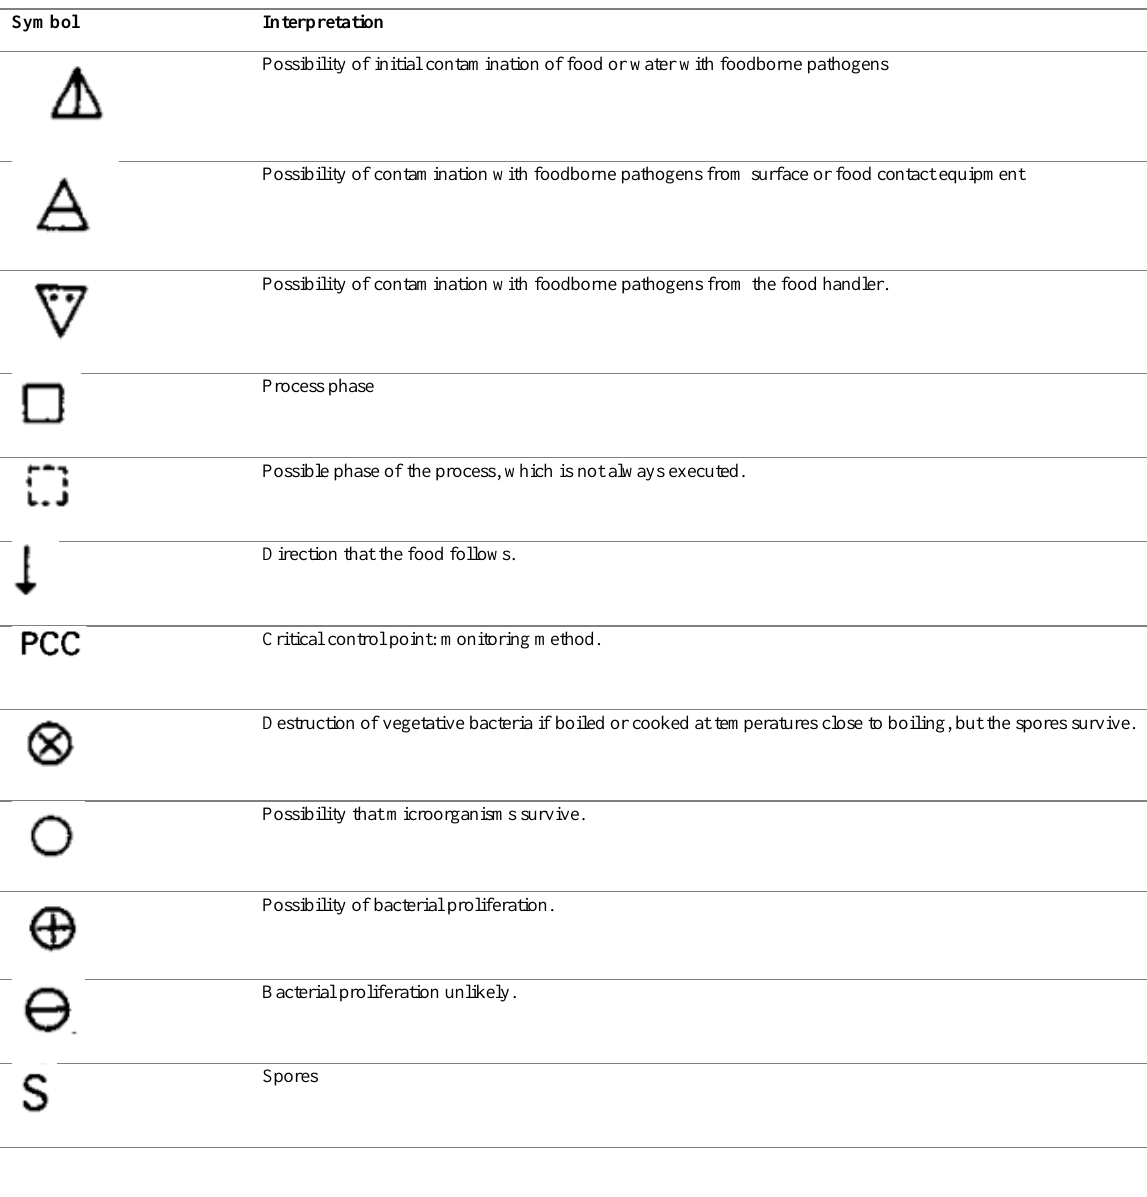
Table 1: Symbols used in food flow